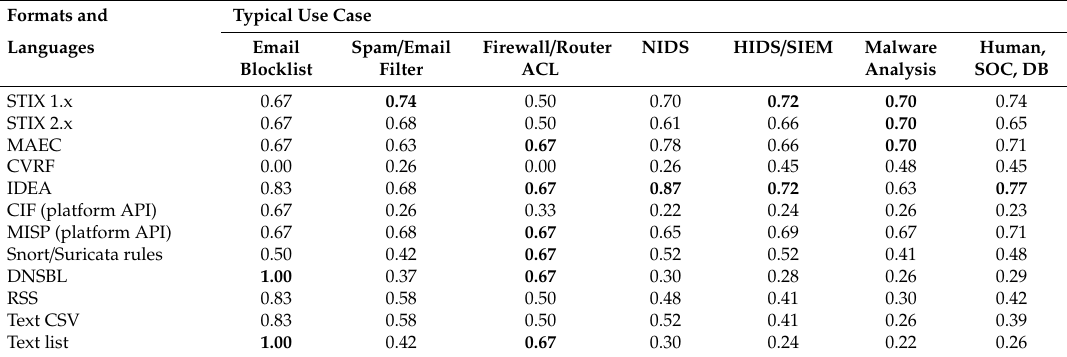
Table 9. Formats and languages suitability per use